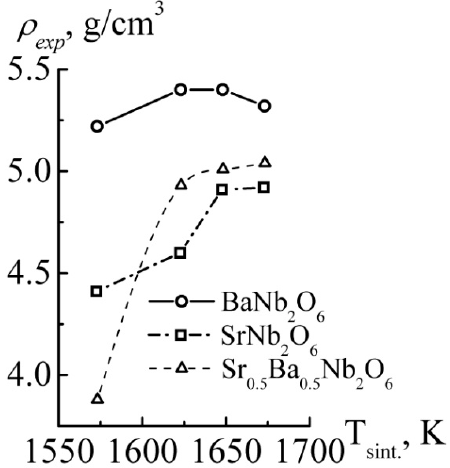
Figure 1. Dependence of experimental density, ρ exp. , on sintering temperature, Т sint. , for BaNb 2 O 6 , SrNb 2 O 6 , Ba 0.5 Sr 0.5 Nb 2 O 6 .